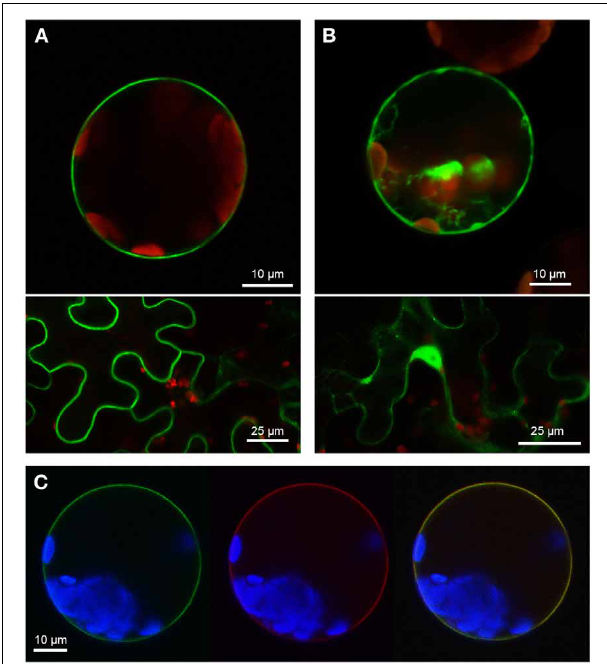
FIGURE 5 | Localization of SAUL-type PUB-ARM proteins from Physcomitrella patens at the plasma membrane. (A) Confocal analysis of fluorescence of Arabidopsis leaf protoplasts (top panel) and tobacco leaf epidermal cells (bottom panel) expressing GFP-Pp1s3_414V6 fusion proteins. GFP fluorescence depicted in green was detected at the plasma membrane in both cell types. Chlorophyll auto-fluorescence within the chloroplasts is depicted in red. (B) Confocal analysis of fluorescence of Arabidopsis leaf protoplasts (top panel) and tobacco leaf epidermal cells (bottom panel) expressing GFP-Pp1s67_203V6 fusion proteins. GFP fluorescence depicted in green was detected in cytosol and nucleus in both cell types. Chlorophyll auto-fluorescence within the chloroplasts is depicted in red. (C) Localization of GFP-Pp1s3_414V6 fusion proteins at the plasma membrane of Arabidopsis protoplasts. Confocal laser scanning microscopy detected fluorescence of GFP-Pp1s3_414V6 proteins depicted in green (left) and RFP-UmSrt1 (middle) proteins depicted in red at the plasma membrane of protoplasts co-expressing GFP-Pp1s3_414V6 and RFP-UmSrt1. Merging both images resulted in yellow signals (right) derived from the overlap of green (GFP-Pp1s3_414V6) and red (RFP-UmSrt1) fluorescences. Chlorophyll auto-fluorescence within the chloroplasts is depicted in